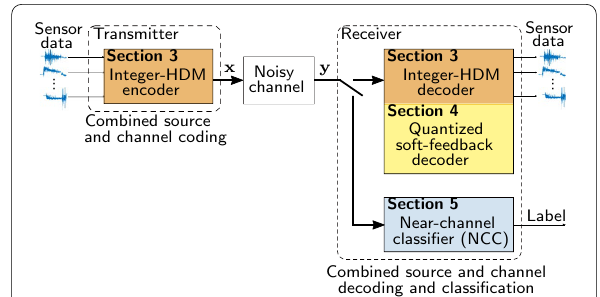
Fig. 1 Overview of this work with colors pointing to Sects. 3, 4 and 5 in the paper. Sensor data are encoded to high-dimensional vector x ∈ Z D using a novel Integer-HDM encoder and transmitted over a noisy channel. At the receiver, the perturbed vector y is either decomposed by an optimized soft-feedback decoder (that improved Integer-HDM decoder) to reconstruct the sensory data, or directly classified by a near-channel classifier (NCC) without any decoding